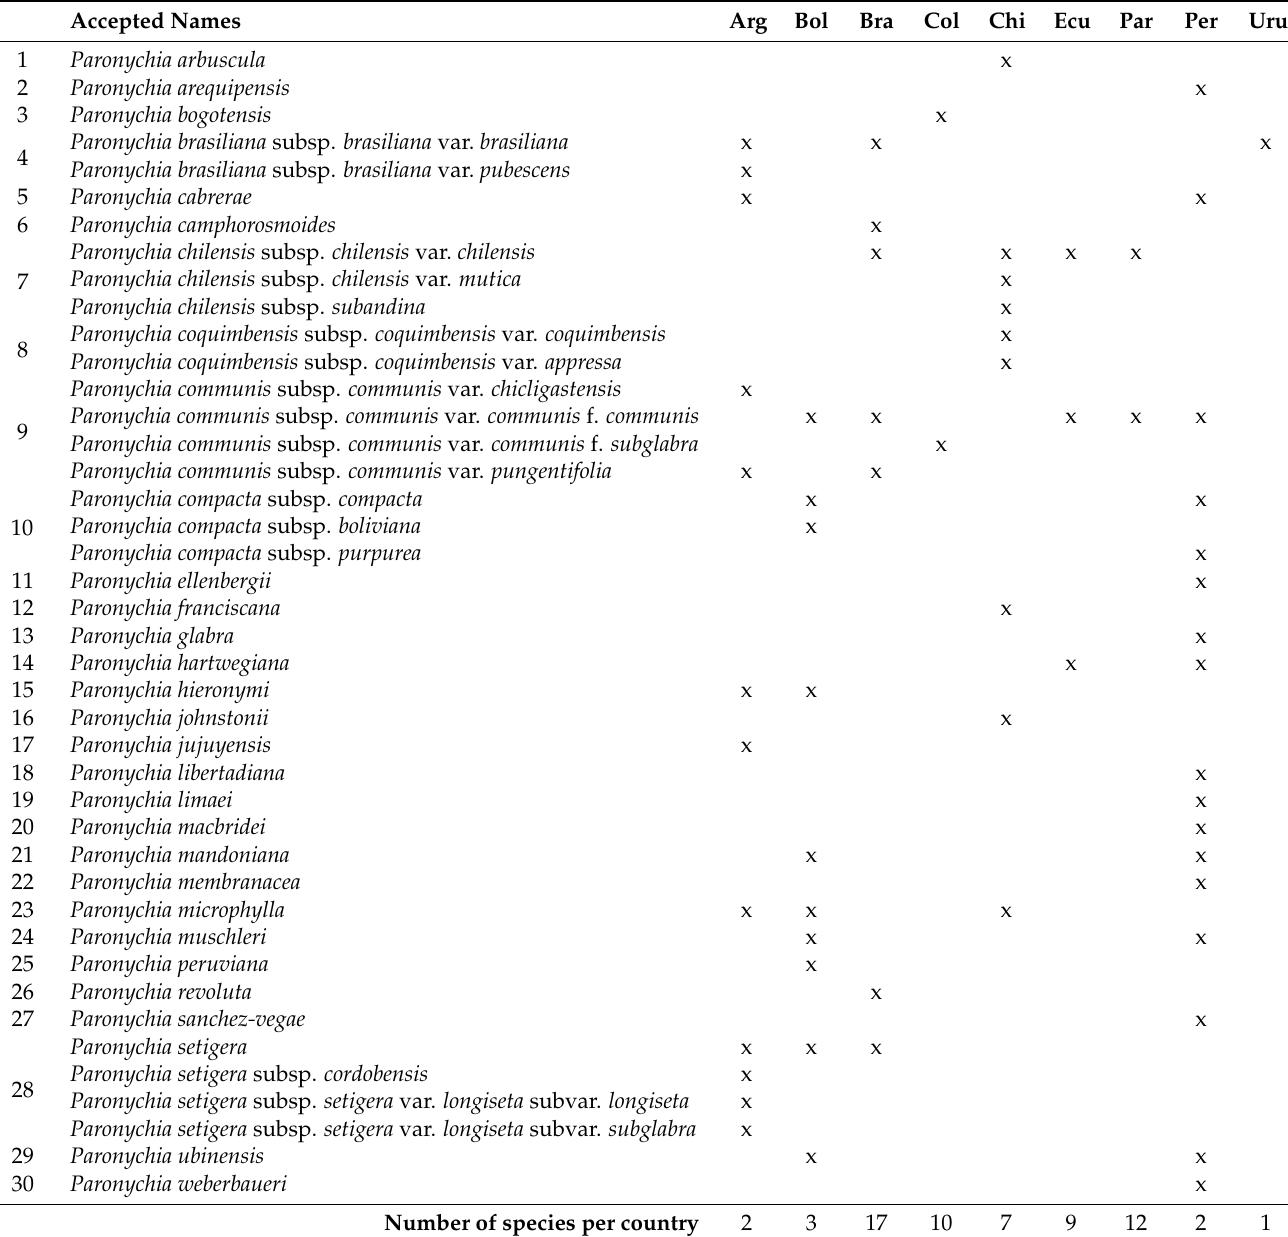
Table 1. South American Paronychia taxa here recognized and their occurrence at national level. Abrbeviations of coutries names: Arg = Argentina; Bol = Bolivia; Bra = Brazil; Col = Colombia; Chi = Chile; Par = Paraguay; Per = Peru; Uru =